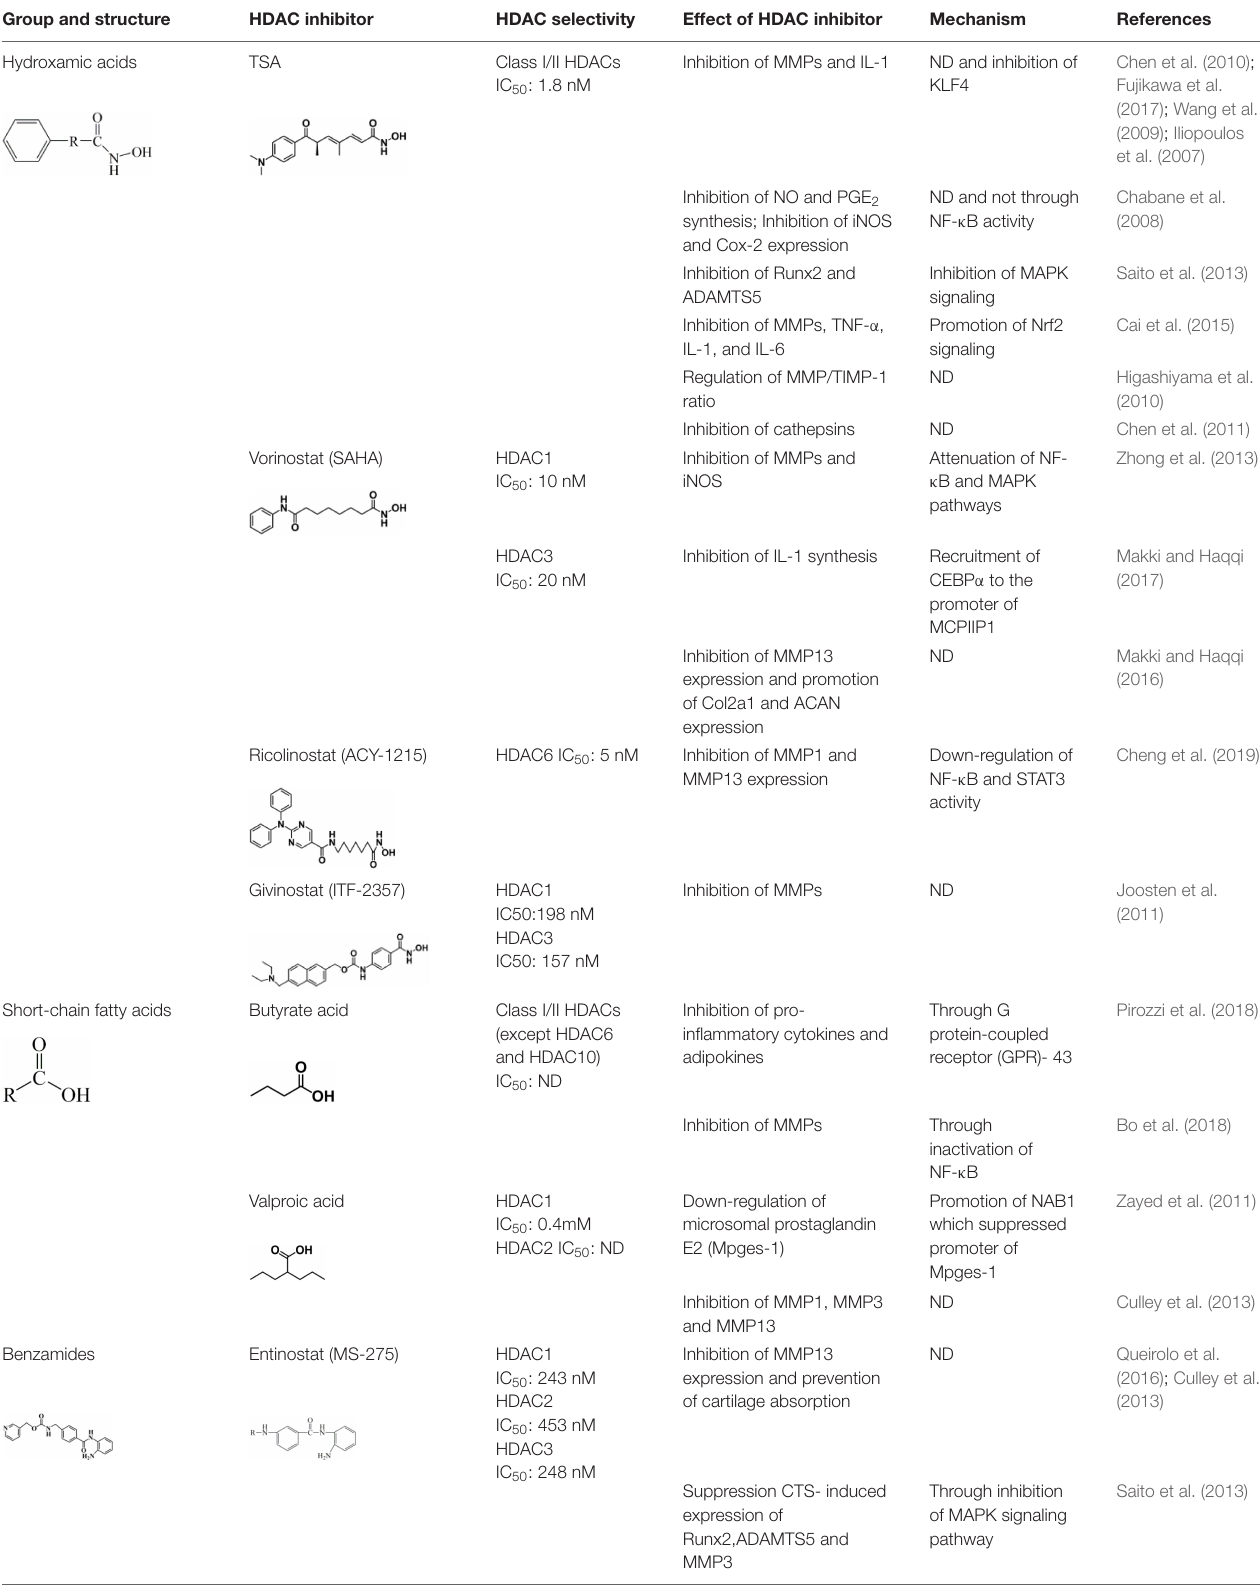
TABLE 2 | The classification of HDACi and effect of HDACi on